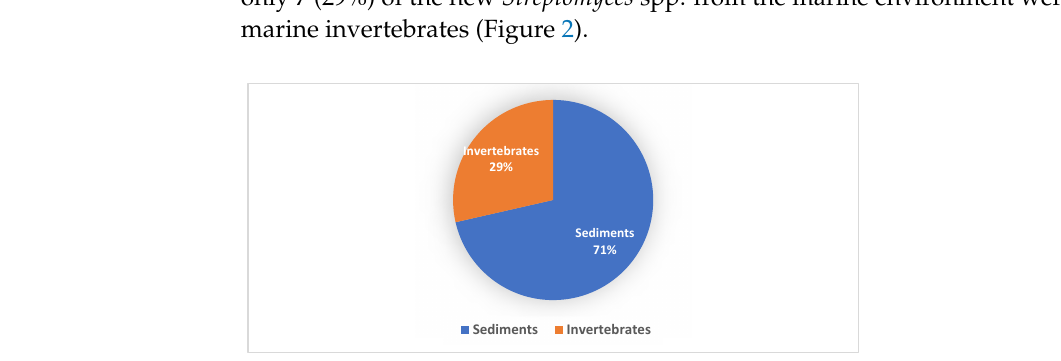
Figure 2. Marine sources of novel Streptomyces spp. between 2015 and 2020 shows 71% of the total novel Streptomyces spp. originated from sediments and 29% were isolated from marine inverte- brates.